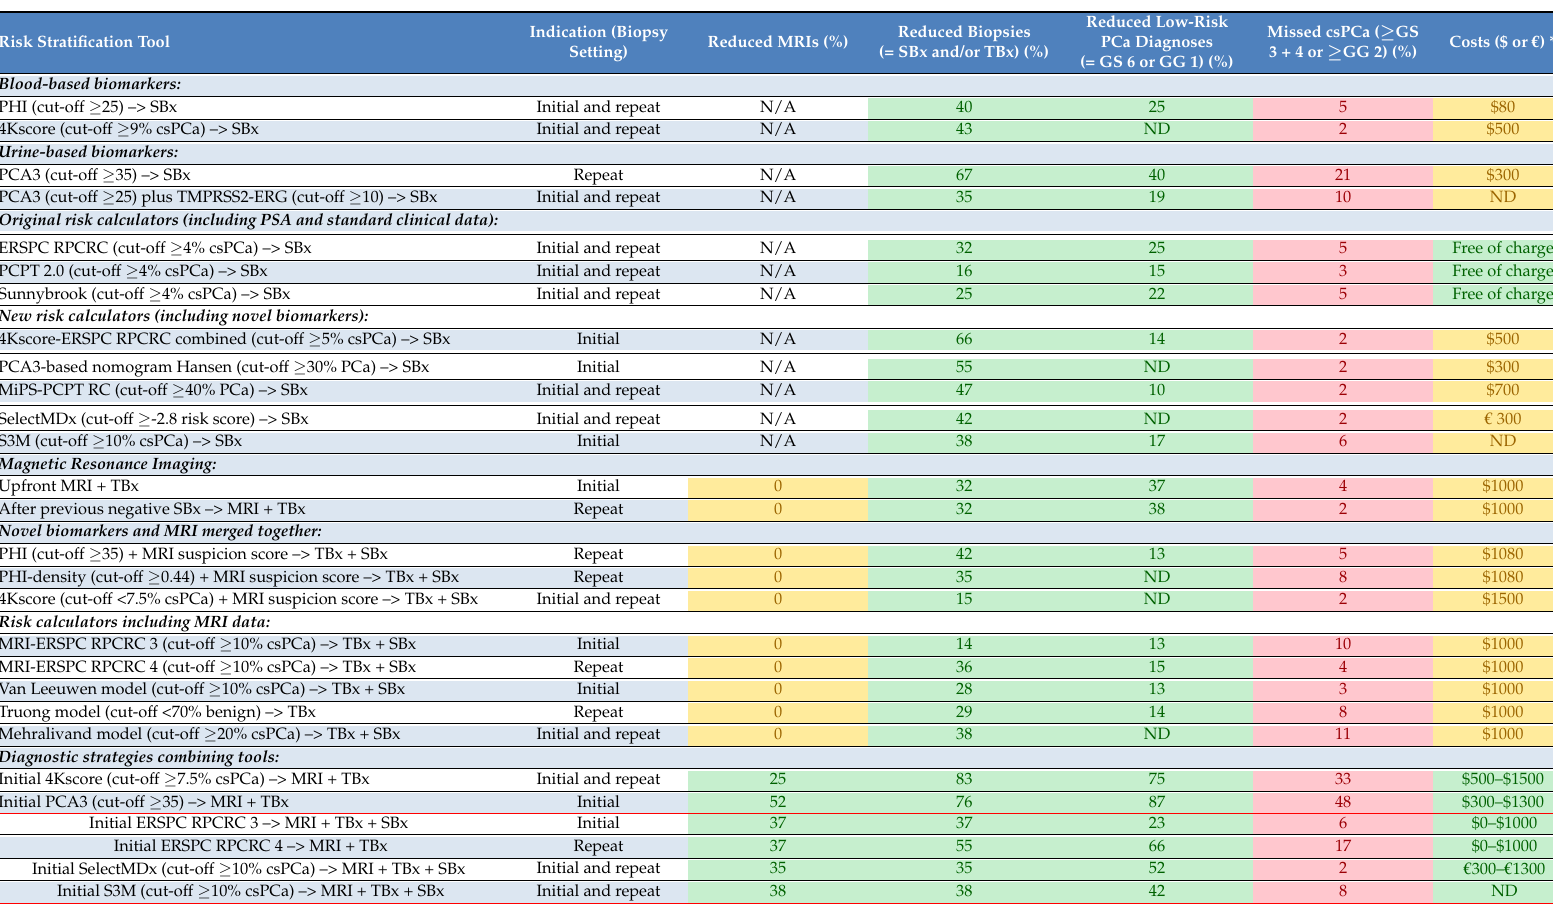
Table 1. Summary table with the performances of currently available risk stratification tools (as standalone tests and merged together) and the diagnostic pathways that combine the tools in the detection of clinically significant prostate cancer (csPCa) (all on average; results can differ between populations). Risk Stratification Tool